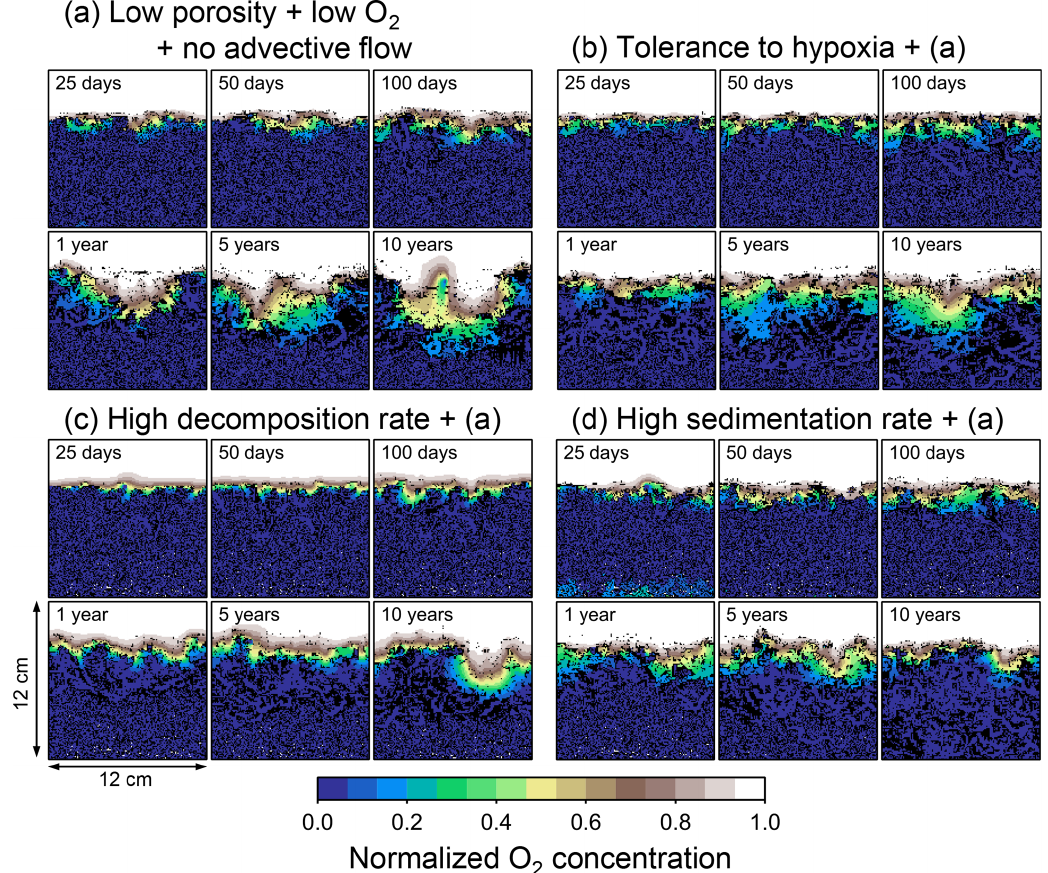
Figure 12. Time evolution of oxygen profiles calculated from 10-year simulations with eLABS. Four different simulations were conducted (Sect. 3.3): (a) with low porosity, no advective water flow and 10 × lower oxygen concentration for seawater but otherwise default settings, (b) additionally assuming organisms to have tolerance to oxygen-depleted conditions, (c) with 10 × higher rate for aerobic decomposition of organic matter but otherwise the same settings as in panel (a) , and (d) with 10 × higher sedimentation rate but otherwise the same settings as in panel (a) . Shown are the profiles of oxygen concentration normalized to the constant boundary value (2 . 2 × 10 − 5 molL − 1 ) at the top layer of the grid at 25, 50, and 100 model days and 1, 5, and 10 model years from the start of the